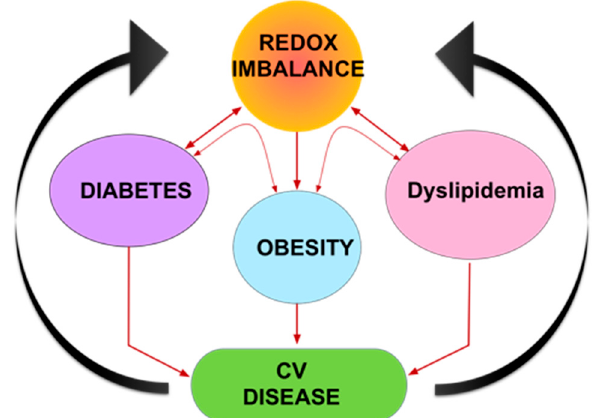
Figure 1. Oxidative Stress Imbalance. Redox imbalance is central to the pathophysiology of chronic disorders, including obesity, metabolic syndrome, and cardiovascular diseases, such as atherosclerosis, and diabetes. These disorders are intertwined in a vicious, feed-forward loop of oxidative stress, which eventually leads to the development of end organ damage that is frequently seen with chronic disorders like these.